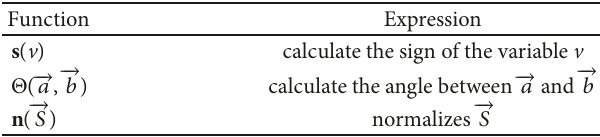
Table 1: Mathematical function